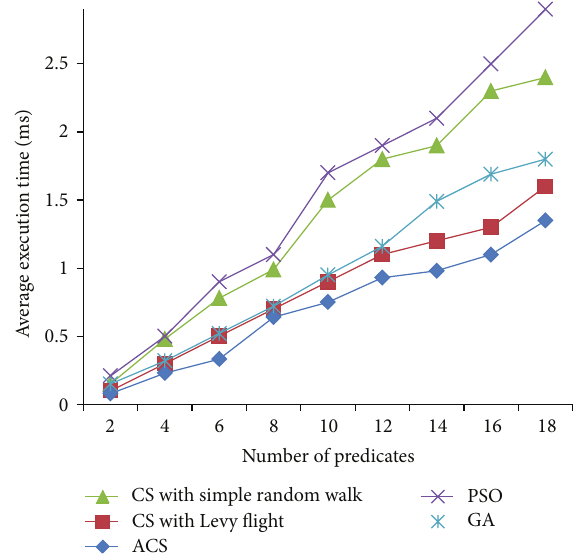
Figure 7: Average execution times (CIA World FactBook dataset).